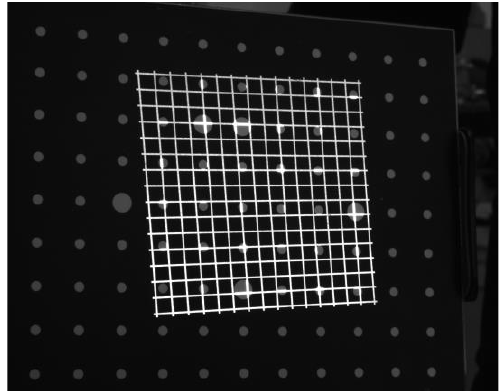
Figure 4. Grid pattern on the calibration board.